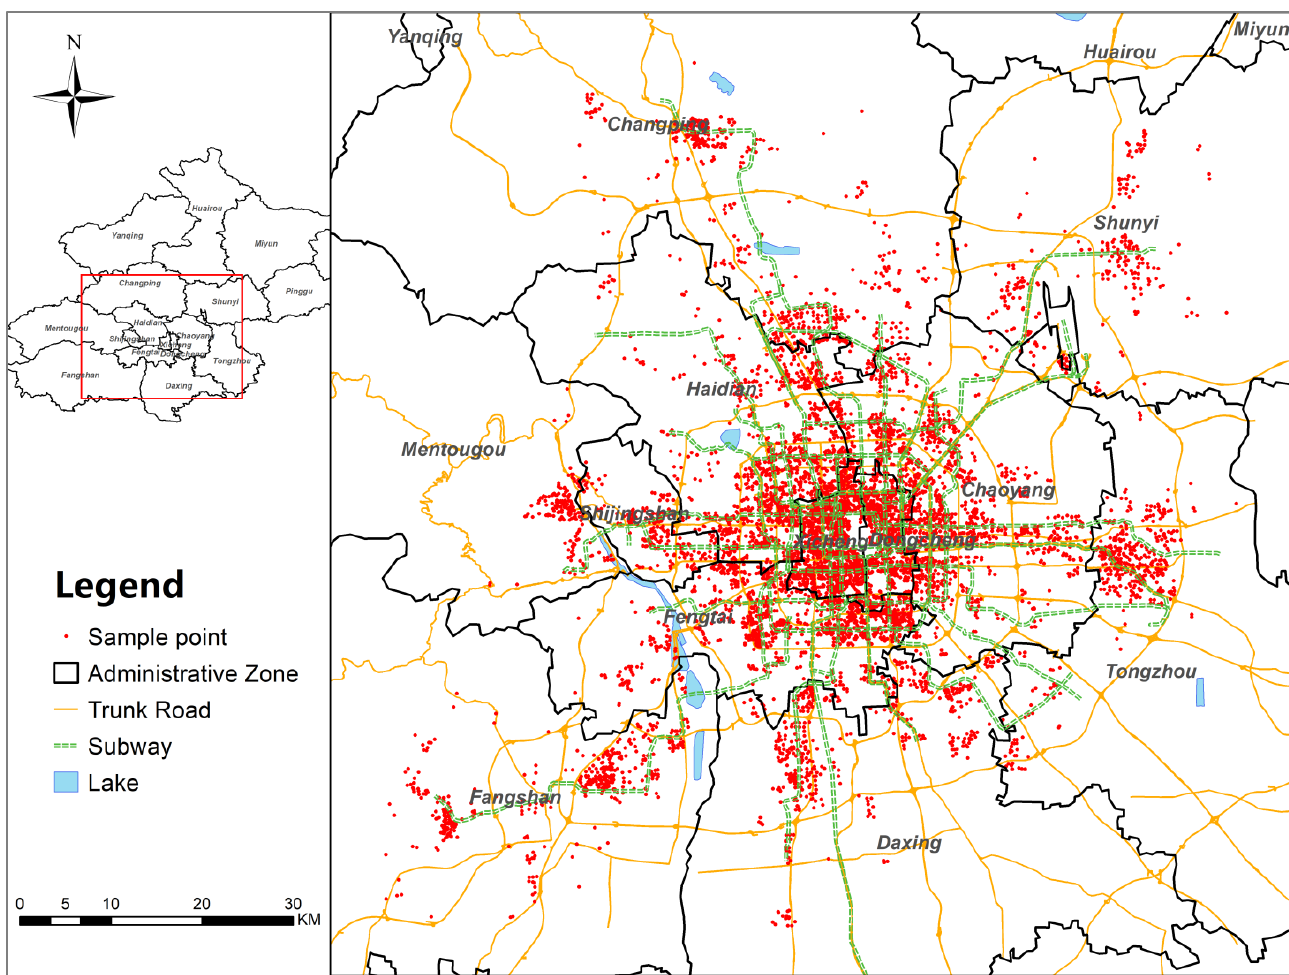
Figure 1. Distribution map of sampling points in Beijing.